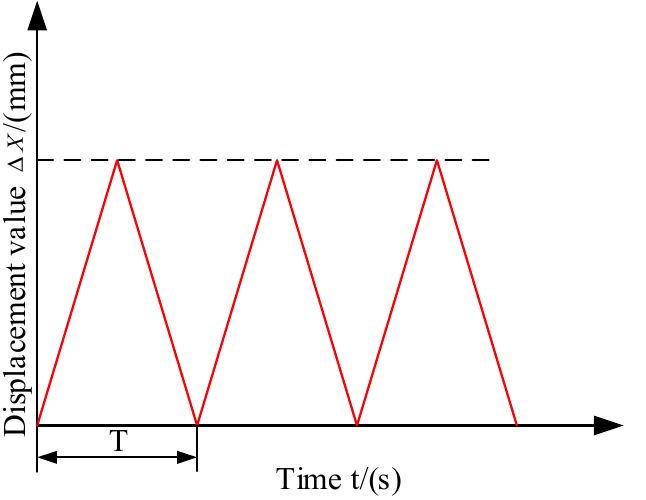
Figure 13. Tubing loading time displacement curve.